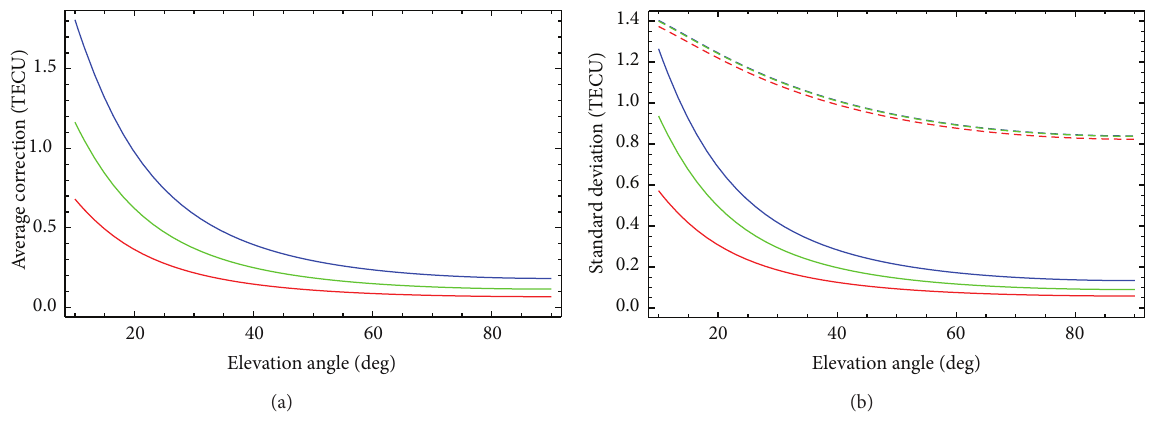
Figure 2: The same as in Figure 1 for geometry-free combination